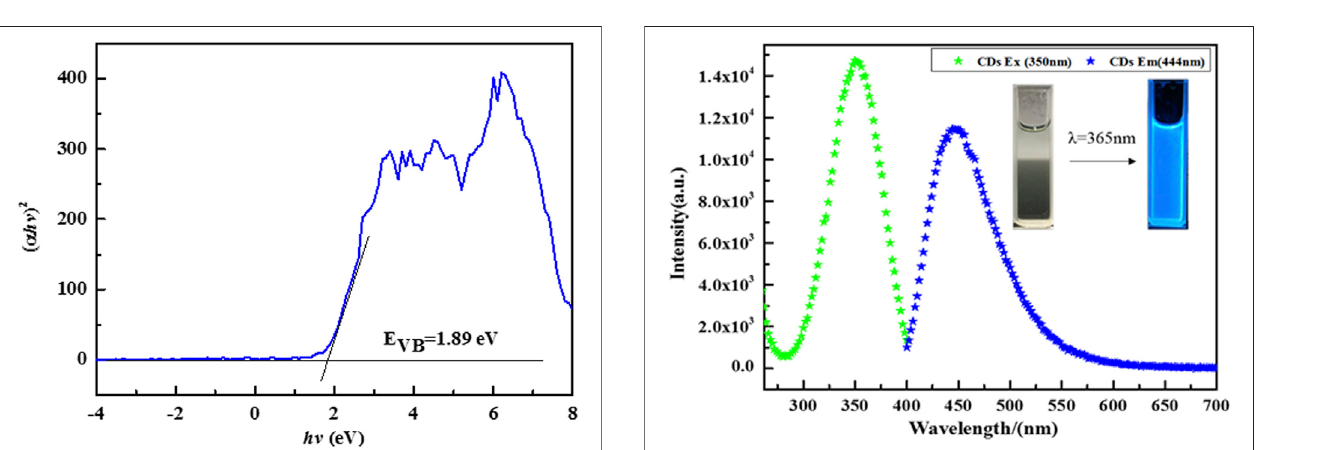
FIGURE 5 | The bandgap energy of 0.2CD-TNs.